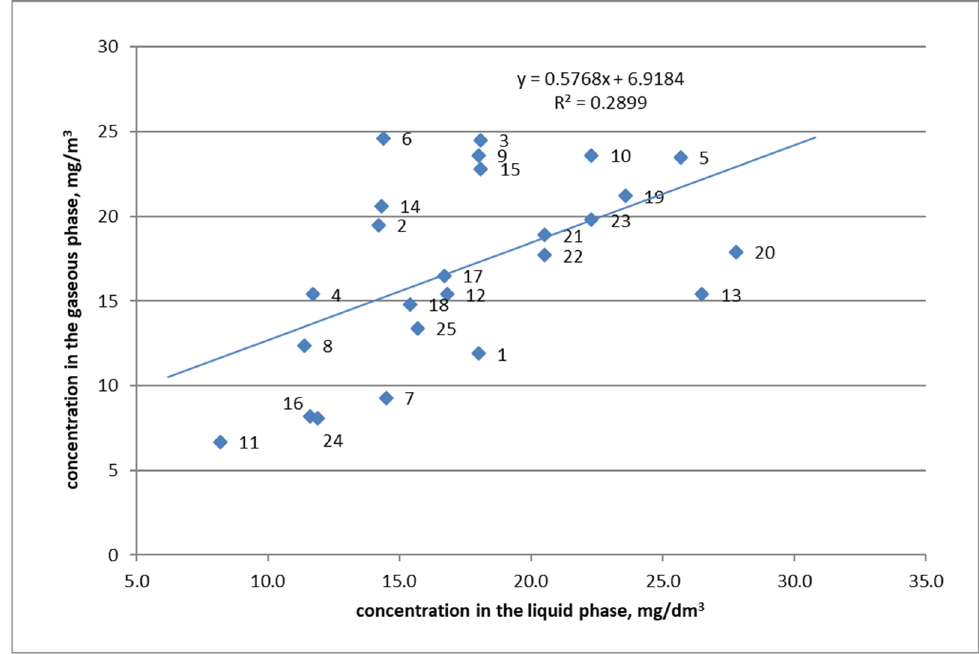
Figure 10. Concentration of benzene in the liquid and gaseous phases of diesel oil in equilibrium.